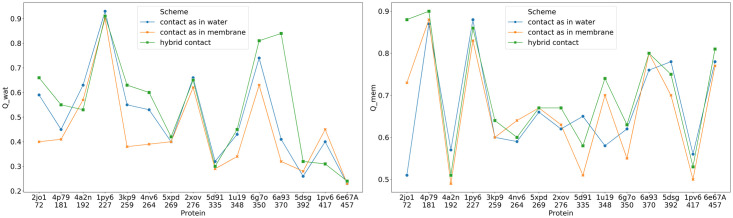
Structure prediction results using the three contact potential schemes evaluated using Qwater (left) and Qmem (right).Qwater measures the structural similarity to the native structure using only the residues that are outside of the membrane, whereas Qmem measures the structural similarity of the structures for those residues found inside the membrane. The closer the similarity score is to 1.0, the more native like is the prediction. The hybrid potential in general performs better than either the pure globular protein model or the pure membrane model.